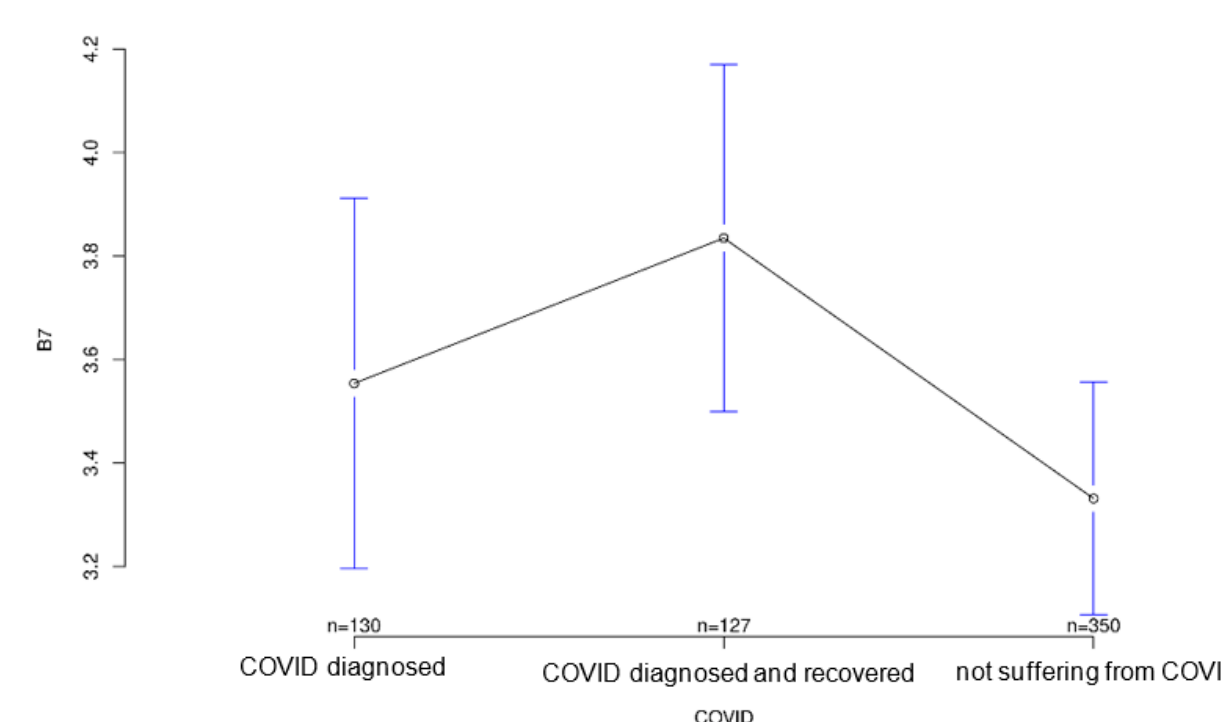
physicians.” The y -axis shows the mean result of participants choice on the Likert scale.